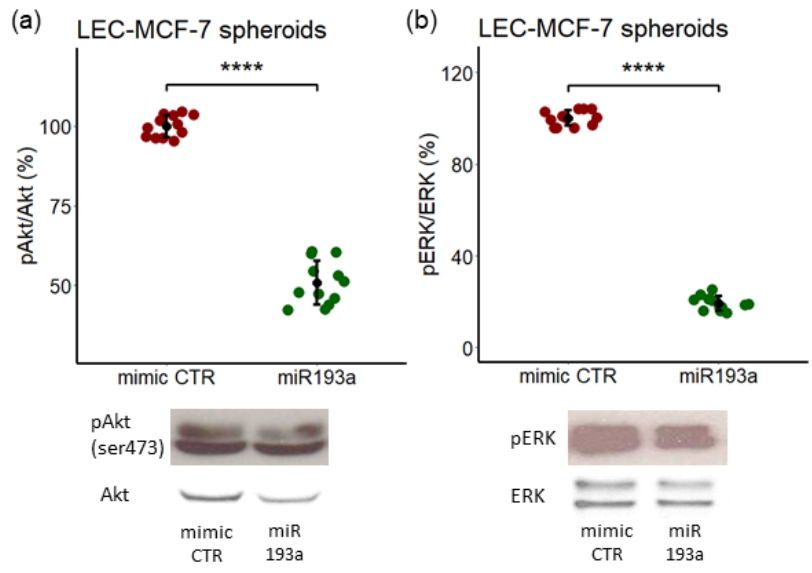
Figure 3. MicroRNA193a (miR193a) inhibits Akt and ERK phosphorylation in LEC + MCF-7 spheroids. Representative Western blots and graphs depicting the inhibition Akt ( a ) and ERK ( b ) phosphorylation in LECs + MCF-7 spheroids transfected with miR193a-3p. Cells were transfected with 25 nM of mimic CTR and miR193a using Lipofectamine2000 and seeded in a U-bottom plate in a 2.5% steroid calf serum medium. Total Akt and ERK were used as the loading control. Western blot analysis was performed on whole spheroid lysates and the band intensity was quantitatively determined using ImageJ software. Experiments were performed at least three times in triplicates and data are represented as mean ± SD. p < 0.0001 **** compared to the respective control.